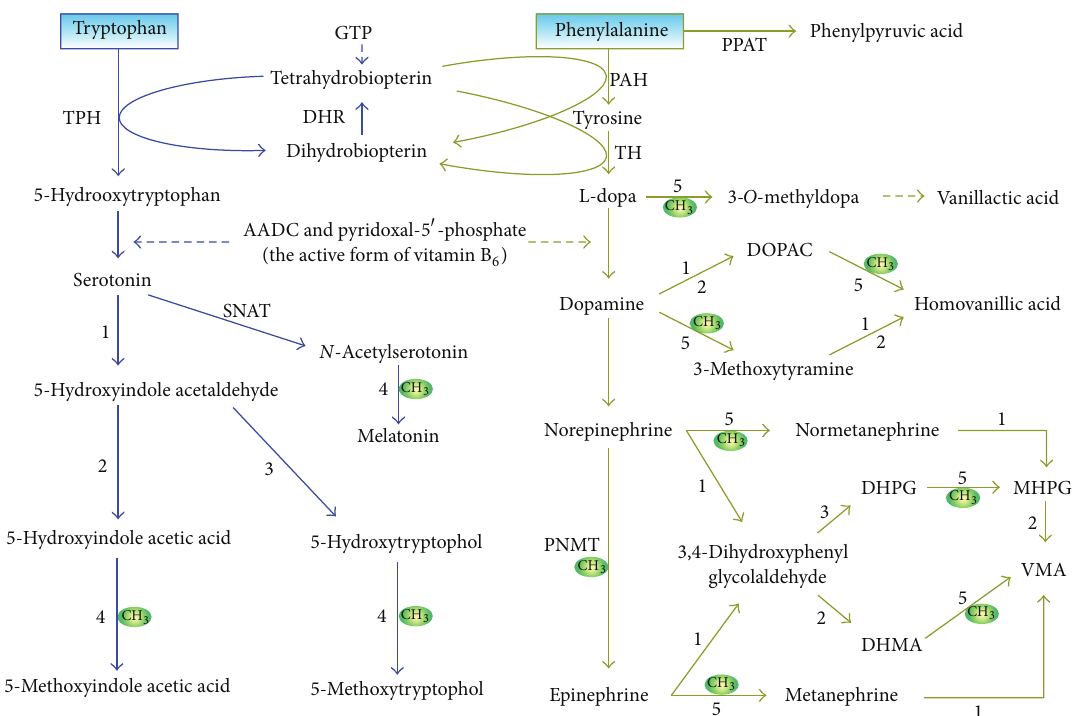
Figure 1: The synthesis and degradation of serotonin and catecholamines. Oxidative deamination and methylation are two key mechanisms for inactivating monoamine neurotransmitters. Note that without labile methyl groups, methylation-mediated degradation of serotonin and catecholamines cannot take place, even though the methyltransferases involved are normal. 1, monoamine oxidase; 2, aldehyde dehydrogenase; 3, aldehyde reductase; 4, acetylserotonin O -methyltransferase; 5, catechol- O -methyltransferase. AADC: aromatic L- amino acid decarboxylase; DHMA: 3,4-dihydroxymandelic acid; DHPG: 3,4-dihydroxyphenylglycol; DHR: dihydropteridine reductase; DOPAC: 3,4-dihydroxyphenylacetic acid; GTP: guanosine triphosphate; MHPG: 3-methoxy-4-hydroxyphenylglycol; PAH: phenylalanine hydroxylase;PNMT:phenylethanolamine N -methyltransferase;PPAT:phenylalanine(histidine):pyruvateaminotransferase;SNAT:serotonin N -acetyltransferase; TH, tyrosine-3-hydroxylase; TPH, tryptophan-5-hydroxylase; VMA: vanillylmandelic